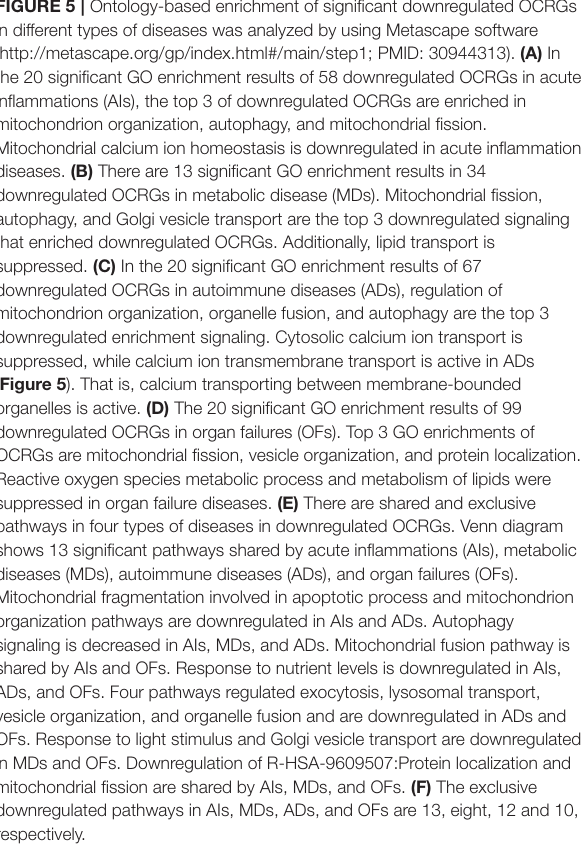
FIGURE 5 | Ontology-based enrichment of significant downregulated OCRGs in different types of diseases was analyzed by using Metascape software (http://metascape.org/gp/index.html#/main/step1; PMID: 30944313). (A) In the 20 significant GO enrichment results of 58 downregulated OCRGs in acute inflammations (AIs), the top 3 of downregulated OCRGs are enriched in mitochondrion organization, autophagy, and mitochondrial fission. Mitochondrial calcium ion homeostasis is downregulated in acute inflammation diseases. (B) There are 13 significant GO enrichment results in 34 downregulated OCRGs in metabolic disease (MDs). Mitochondrial fission, autophagy, and Golgi vesicle transport are the top 3 downregulated signaling that enriched downregulated OCRGs. Additionally, lipid transport is suppressed. (C) In the 20 significant GO enrichment results of 67 downregulated OCRGs in autoimmune diseases (ADs), regulation of mitochondrion organization, organelle fusion, and autophagy are the top 3 downregulated enrichment signaling. Cytosolic calcium ion transport is suppressed, while calcium ion transmembrane transport is active in ADs ( Figure 5 ). That is, calcium transporting between membrane-bounded organelles is active. (D) The 20 significant GO enrichment results of 99 downregulated OCRGs in organ failures (OFs). Top 3 GO enrichments of OCRGs are mitochondrial fission, vesicle organization, and protein localization. Reactive oxygen species metabolic process and metabolism of lipids were suppressed in organ failure diseases. (E) There are shared and exclusive pathways in four types of diseases in downregulated OCRGs. Venn diagram shows 13 significant pathways shared by acute inflammations (AIs), metabolic diseases (MDs), autoimmune diseases (ADs), and organ failures (OFs). Mitochondrial fragmentation involved in apoptotic process and mitochondrion organization pathways are downregulated in AIs and ADs. Autophagy signaling is decreased in AIs, MDs, and ADs. Mitochondrial fusion pathway is shared by AIs and OFs. Response to nutrient levels is downregulated in AIs, ADs, and OFs. Four pathways regulated exocytosis, lysosomal transport, vesicle organization, and organelle fusion and are downregulated in ADs and OFs. Response to light stimulus and Golgi vesicle transport are downregulated in MDs and OFs. Downregulation of R-HSA-9609507:Protein localization and mitochondrial fission are shared by AIs, MDs, and OFs. (F) The exclusive downregulated pathways in AIs, MDs, ADs, and OFs are 13, eight, 12 and 10, respectively.